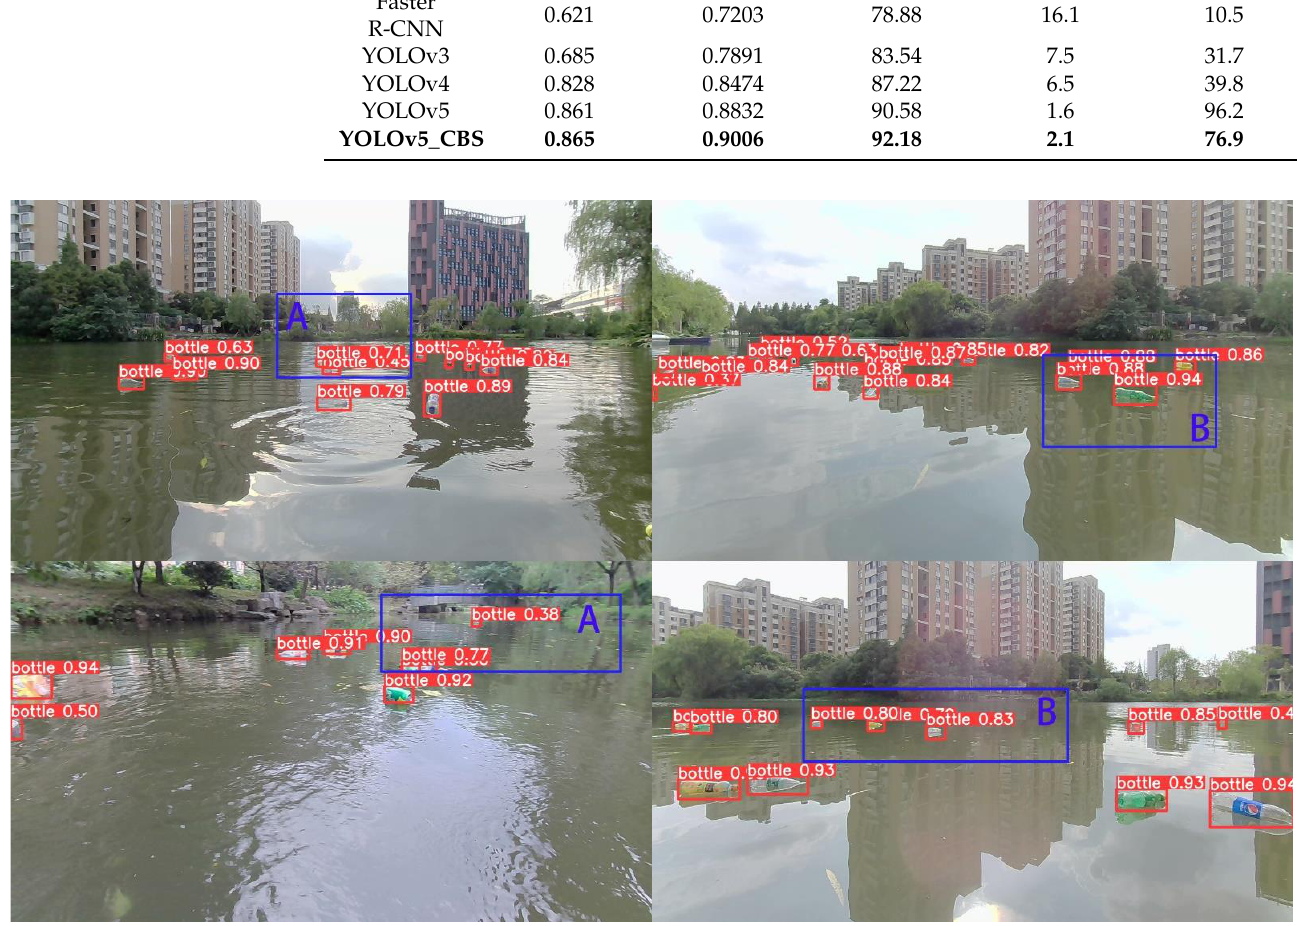
Figure 14. Sample images of the FloW-Img public dataset, revealing some shortcomings of YOLOv5_CBS (e.g., when multiple small objects are present in the images, or when the density of the target objects is high, this may result in a low detection rate and low confidence level, as shown in areas A, or when reflections on the water surface exist, then part of the prediction box may treat the reflection as an object too, or a bigger prediction box, including the reflection, may be formed, as shown in areas B).